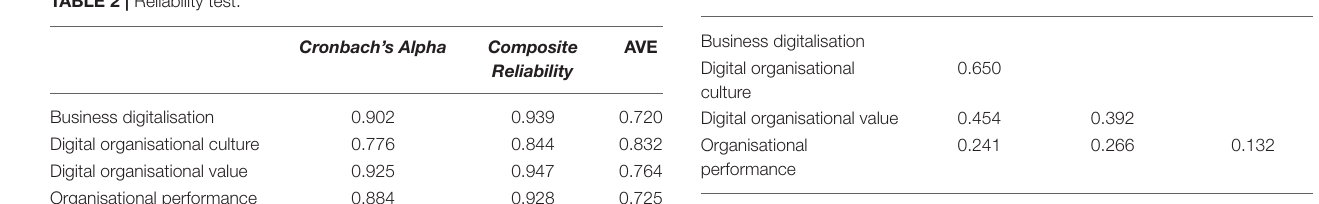
TABLE 2 | Reliability test.